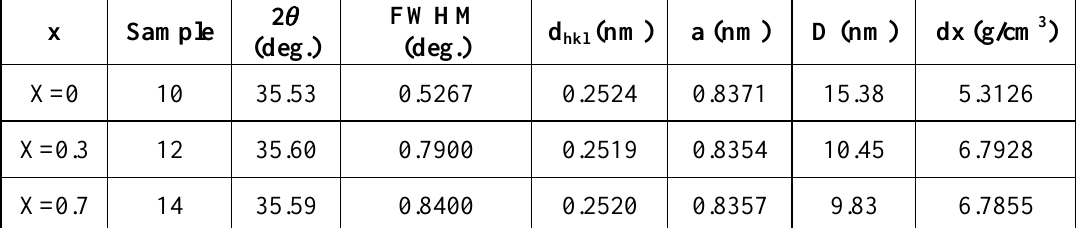
Table 3: Structural properties of the chosen ferrite samples extracted from their XRD